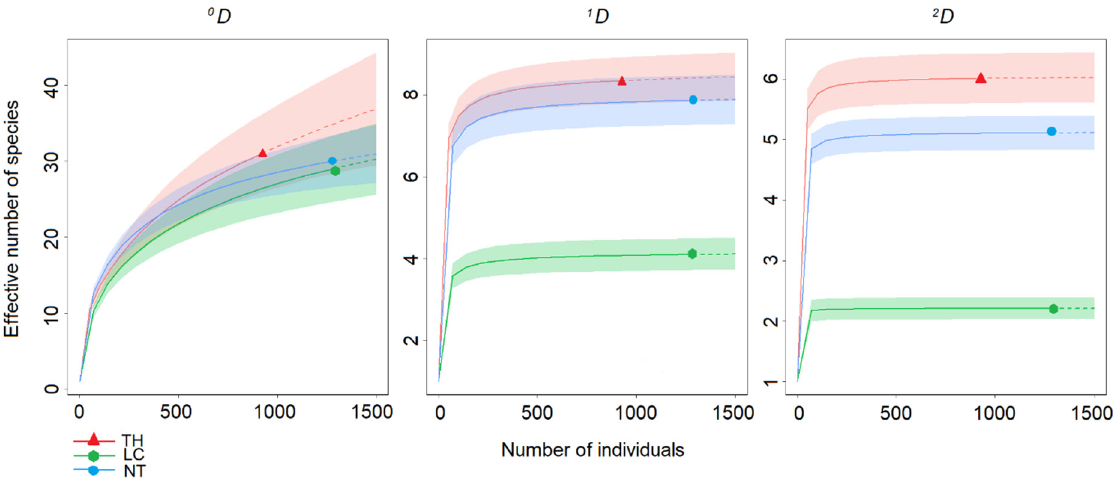
Figure 4. Accumulation curves of tree species in two forest management treatments compared to a site with no treatment in the Ocotones forest, Chiapas, Mexico. Continuous lines indicate interpolation (rarefaction), while broken lines denote extrapolation. Diversity is represented by Hill numbers: 0 D , observed richness; 1 D , common species; 2 D , dominant species. Color bands correspond to the confidence interval at 95%. TH = Thinning II, LC = Liberation cut, and NT = No treatment. Table 1. Accumulated number and percentage of families, genera, and species recorded in different silvicultural treatments in the Ocotones forest, Chiapas, Mexico. Numbers of species are separated according to successional category.